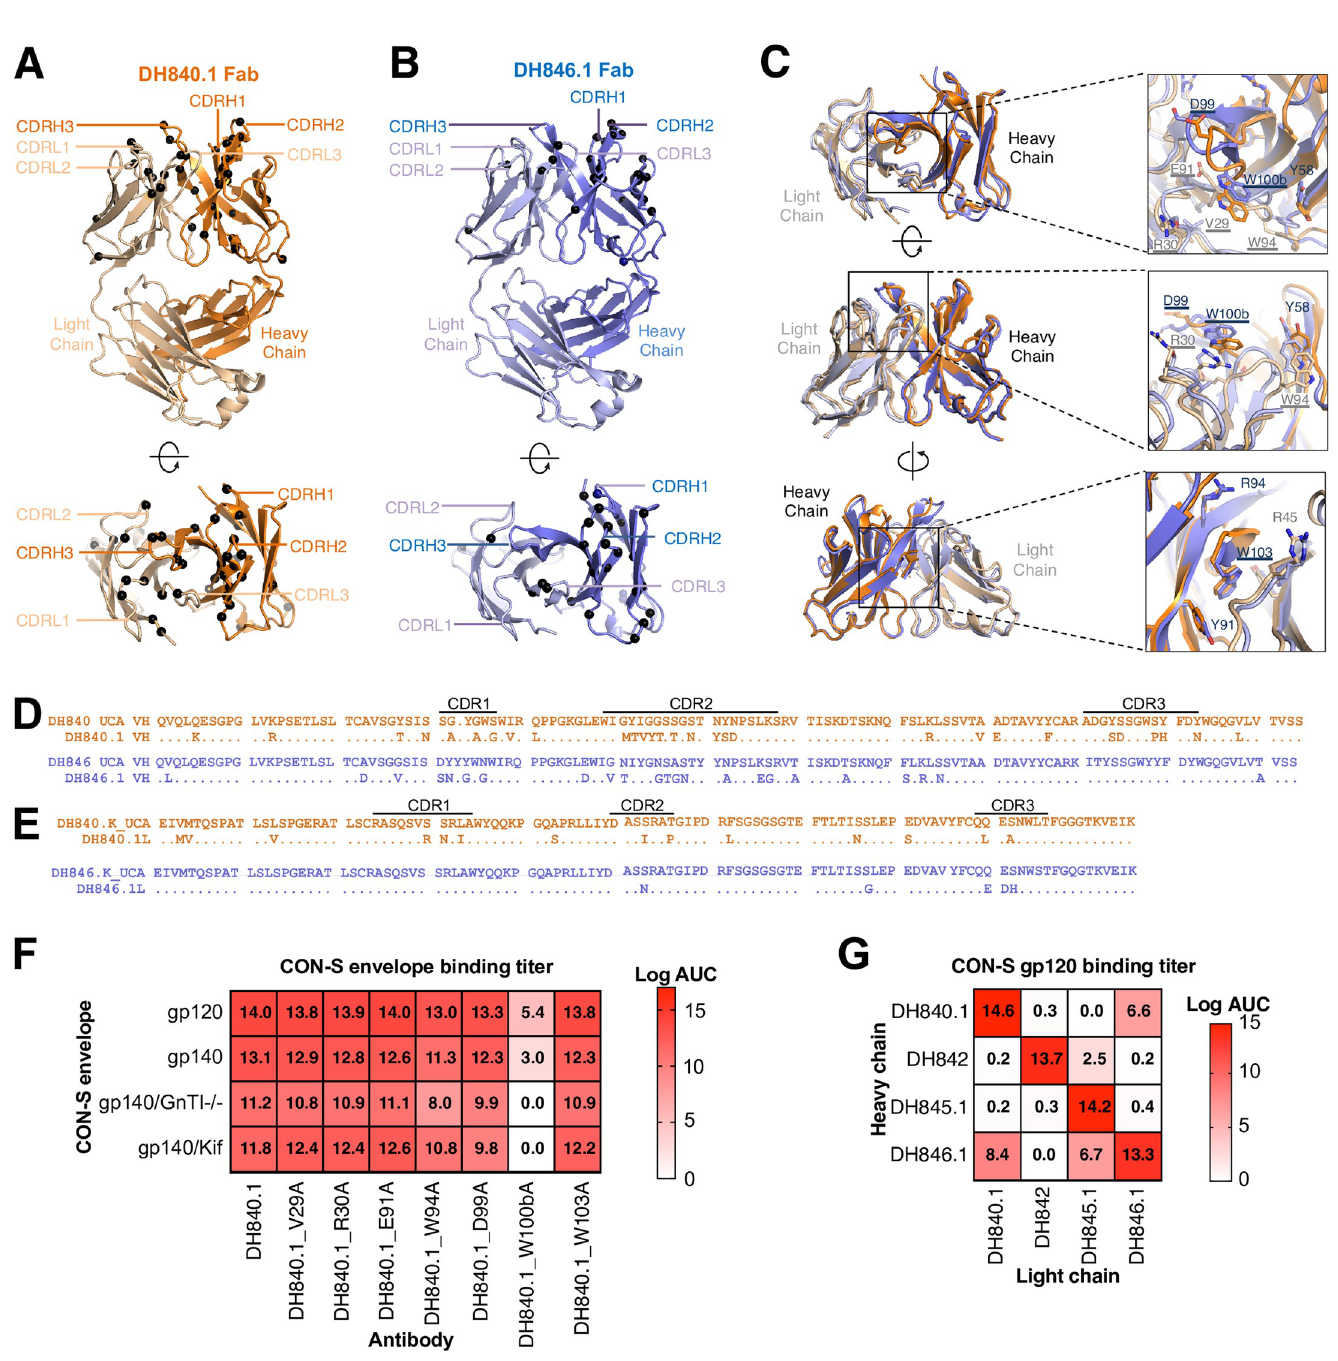
Fig 2. Structural conservation of CON-S neutralizing antibody paratopes. (A,B) Crystal structures of (A) DH840.1 and (B) DH846.1 Fabs shown in ribbon representation in two orientations. Amino acids encoded by nucleotide somatic mutations are indicated by black spheres. (C) DH840.1 and DH846.1 Fabs shown in ribbon representation are structurally overlaid and shown in three orientations. Close-up views of select CDR loop residues from both DH840.1 and DH846.1 that are similar in sequence and location are shown in stick representation, with DH840.1 paratope alanine mutants tested in F underlined for reference. (D,E) Amino acid comparison of DH840.1 (orange), DH846.1 (violet), and their putative unmutated common ancestors. (D) Heavy chain and (E) light chain variable region amino acid sequences. Dots represent identical amino acids. Variable region domains are listed above the amino acid sequence. (F) Antibody binding titers to CON-S envelope by DH840.1 paratope alanine mutants. Binding titer was measured by ELISA, and is shown as the area-under-the-log-transformed curve (log AUC). Kif, kifunensine; GnTI-/-, 293S cells lacking the GnTI enzyme. Mean values of two to four independent measurements are shown. (G) Antibody binding titers as log AUC in ELISA to CON-S envelope for chimeric antibodies composed of heavy and light chains from different CON-S nAb lineages. The binding magnitude is color-coded with stronger binding being darker shades of red. Mean values of four independent measurements are shown.